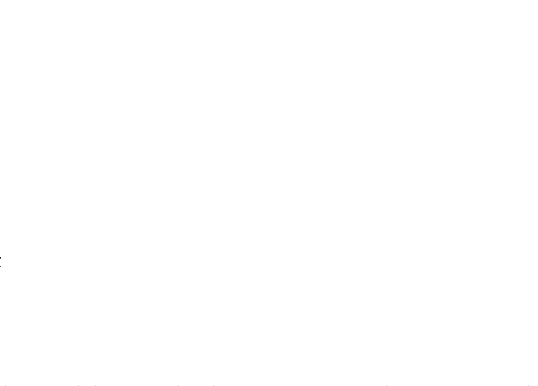
Figure 11. Time history of an impact load used to model impact loading comprising a large magnitude applied for a short time interval.